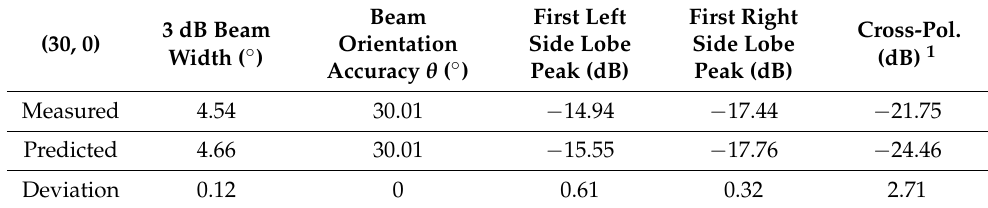
First Right Cross-Pol. Peak (dB)